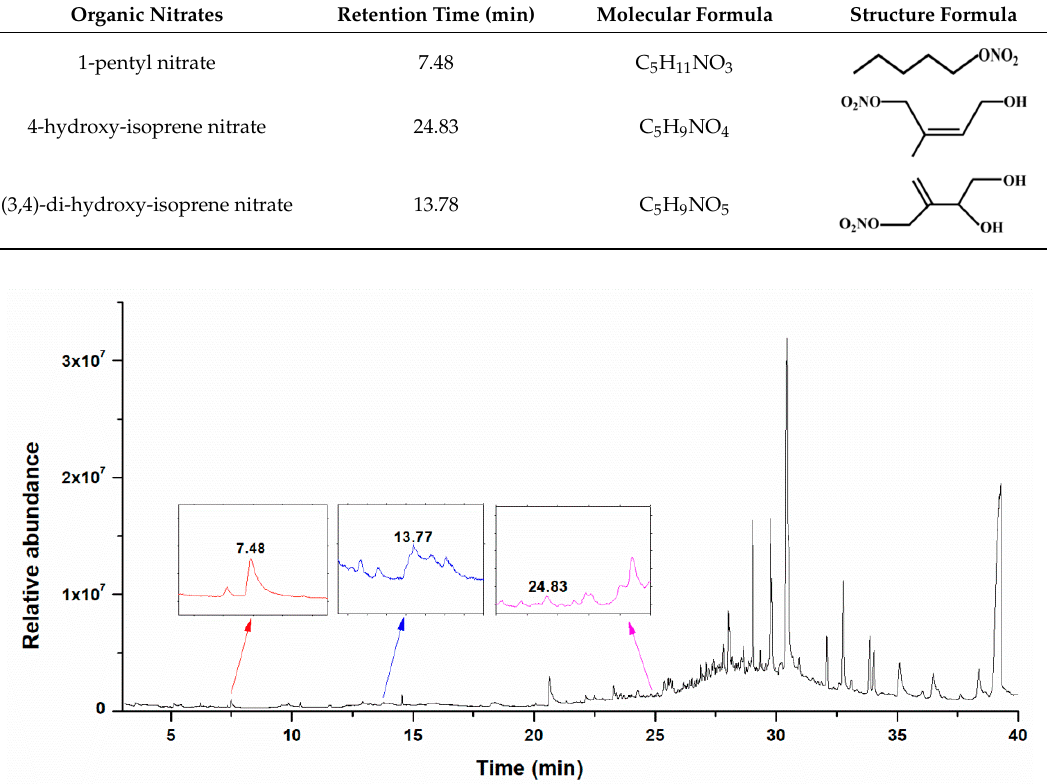
Figure 1. Total ion chromatogram of the semivolatile sample.